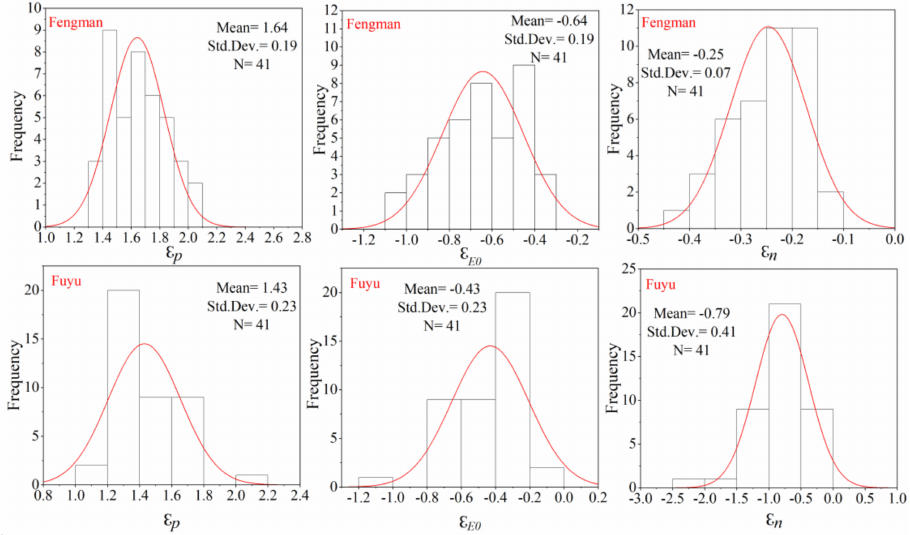
Figure 8. Frequency analysis of ε p , ε n and ε E 0 in the Fengman and Fuyu